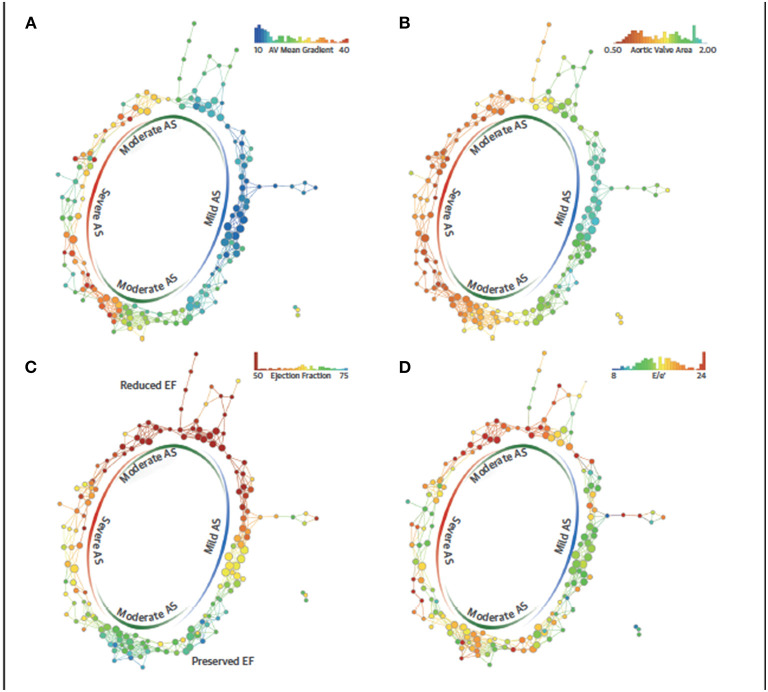
Topological data analysis loop in aortic stenosis. The similarity network draws aggregation of patients with severe and mild AS in 2 opposite ends and moderate AS in the top and bottom arms of the loop. The red color represents the abnormal values, whereas blue represents the normal or minor malady in the disease space. (A) Spectrum of mean gradient in humans identified in the network of disease space. High gradients aggregated on the left side, whereas the low gradients were on the right side with moderate gradients in the middle. (B) Distribution of valve area on the network, (C) patient similarity network revealing preserved and reduced ejection fraction (EFs) in the patients with aortic stenosis (AS). The top arm clustered patients with the reduced EF, whereas the bottom arm described the patients with preserved EF. The red nodes consists of patients with EFs of ≤50%, whereas the blue nodes consists of patients with EFs of ≥65%. (D) Distribution of E/e' as a feature of diastolic dysfunction revealing the pattern of E/e' around moderate and severe AS. TDA, topological data analysis. Adapted from Casaclang-Verzosa et al. (51). Permission obtained from the publisher.